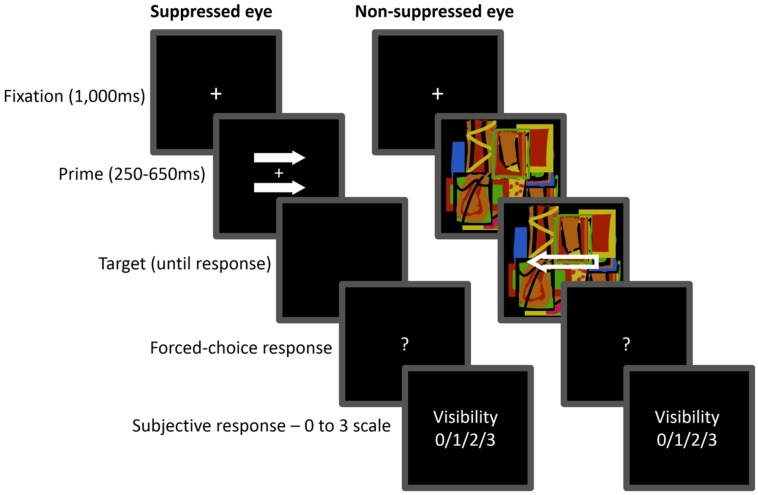
Sequence of events in Experiment 2. The prime arrows were gradually introduced and presented to one eye (suppressed eye), while the target was superimposed on a dynamic Mondrian and presented to the other eye (non-suppressed eye). Here, the directions of the prime and target arrows are incongruent. Participants were required to make a speeded response to the target arrow direction (left or right) and then rate subjective visibility of the prime.